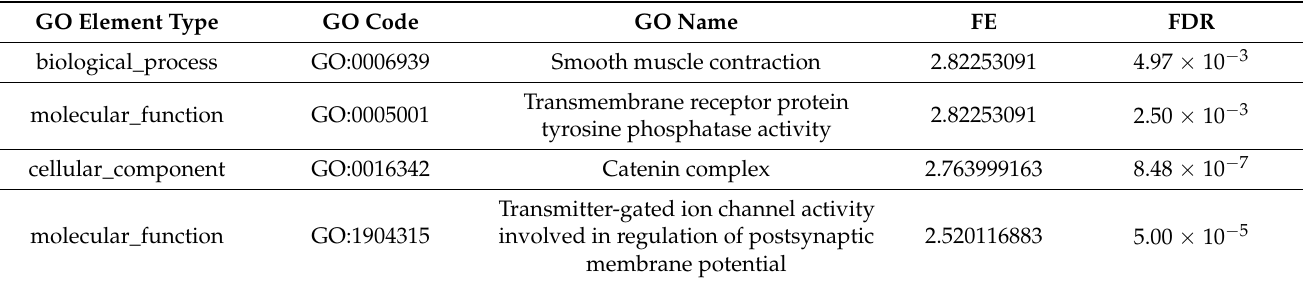
Table 4. Enrichment Analysis for Cluster